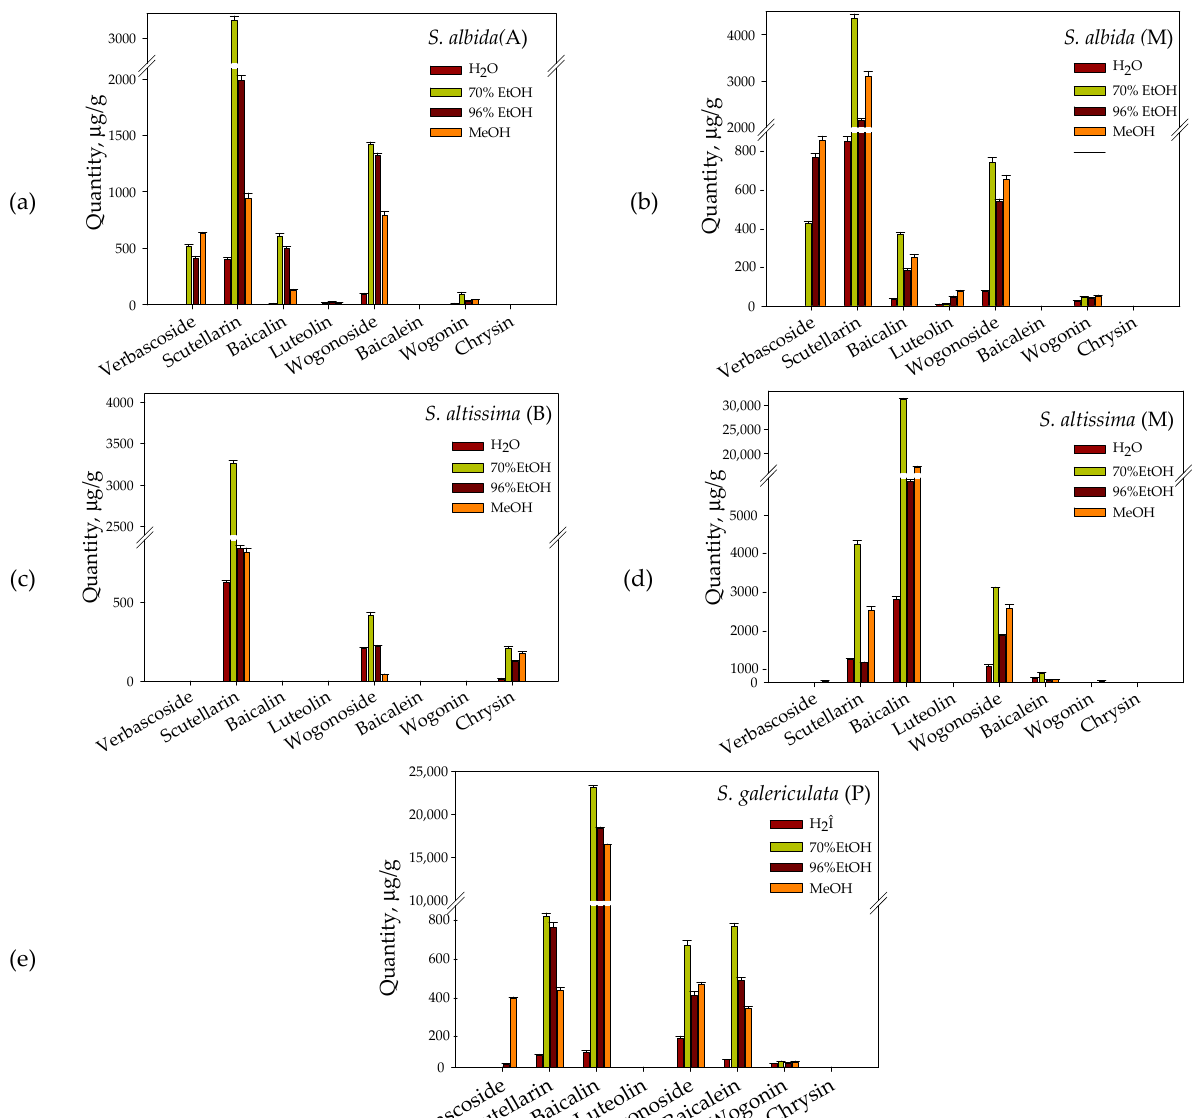
Figure 1. Content of Secondary Metabolites Determined by HPLC in Extracts from: ( a ) S. albida (A); ( b ) S. albida (M); ( c ) S. altissima (B); ( d ) S. altissima (M) and ( e ) S. galericulata (P) obtained with Different Solvents.